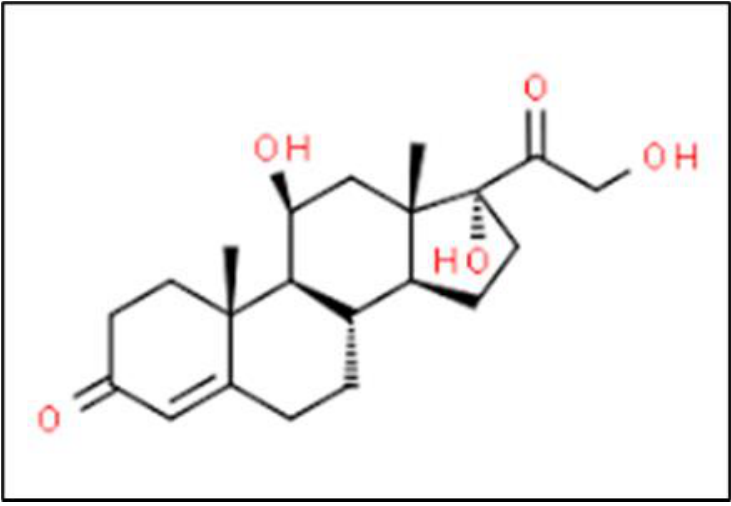
Figure 13. ( A ) A cartoon model, ( B ) a ball-and-stick model, and ( C ) a surface model of CCL11 made using amino acid sequences from the UniProt database [45]. 2.1. GFAP Glial fibrillary acidic protein (GFAP) is an intermediate filament protein predomi- nately expressed in the central nervous system [23]. GFAP measured in the blood is an indicator of TBI, together with abnormal CT scan results right after injury, and poor long- term physical outcome after TBI. 2.2. UCH-L1 Ubiquitin carboxy-terminal hydrolase L1 (UCH-L1) is a deubiquitinase involved in the metabolism removal of other proteins from the cell [25]. Blood concentration of UCH- L1 serves as an indicator of TBI, together with abnormal CT following injury, and poor long-term neurological outcome after TBI. 2.3. MAP-2 Microtubule-associated protein-2 (MAP-2) is a neuron-specific protein that acts to stabilize microtubules [27]. MAP-2 measured in cerebrospinal fluid has limited predictive ability, abnormal head CT results right after TBI injury and good predictive ability of early mortality from TBI. 2.4. NF-L